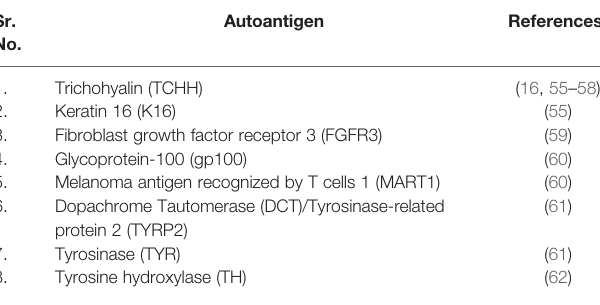
TABLE 1 | List of putative autoantigens identi fi ed in Alopecia